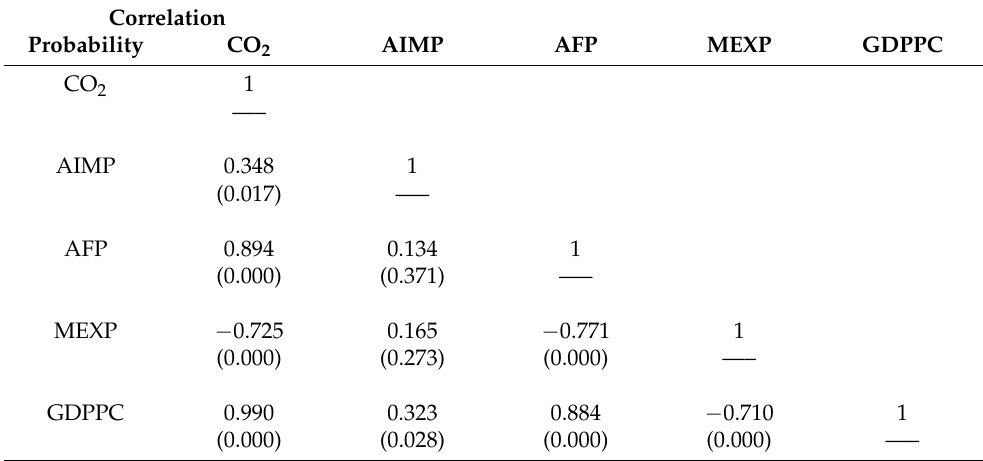
Table 2. Correlation Matrix.